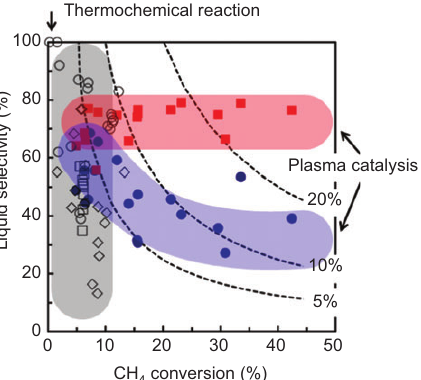
Figure 6 Liquid selectivity vs. methane conversion [ 13 ]. (cid:122) , sum OH, HCHO, HCOOH; (cid:132) , syngas is also counted for liquid of CH 3 selectivity assuming syngas to DME. Three dotted curves represent constant yield lines. Hollow symbols express cited literature;